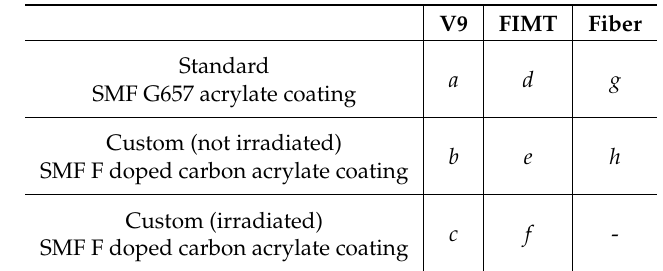
Figure 2. Tested cables: V9 ( a ) and FIMT ( b ) types. Table 1. Tested